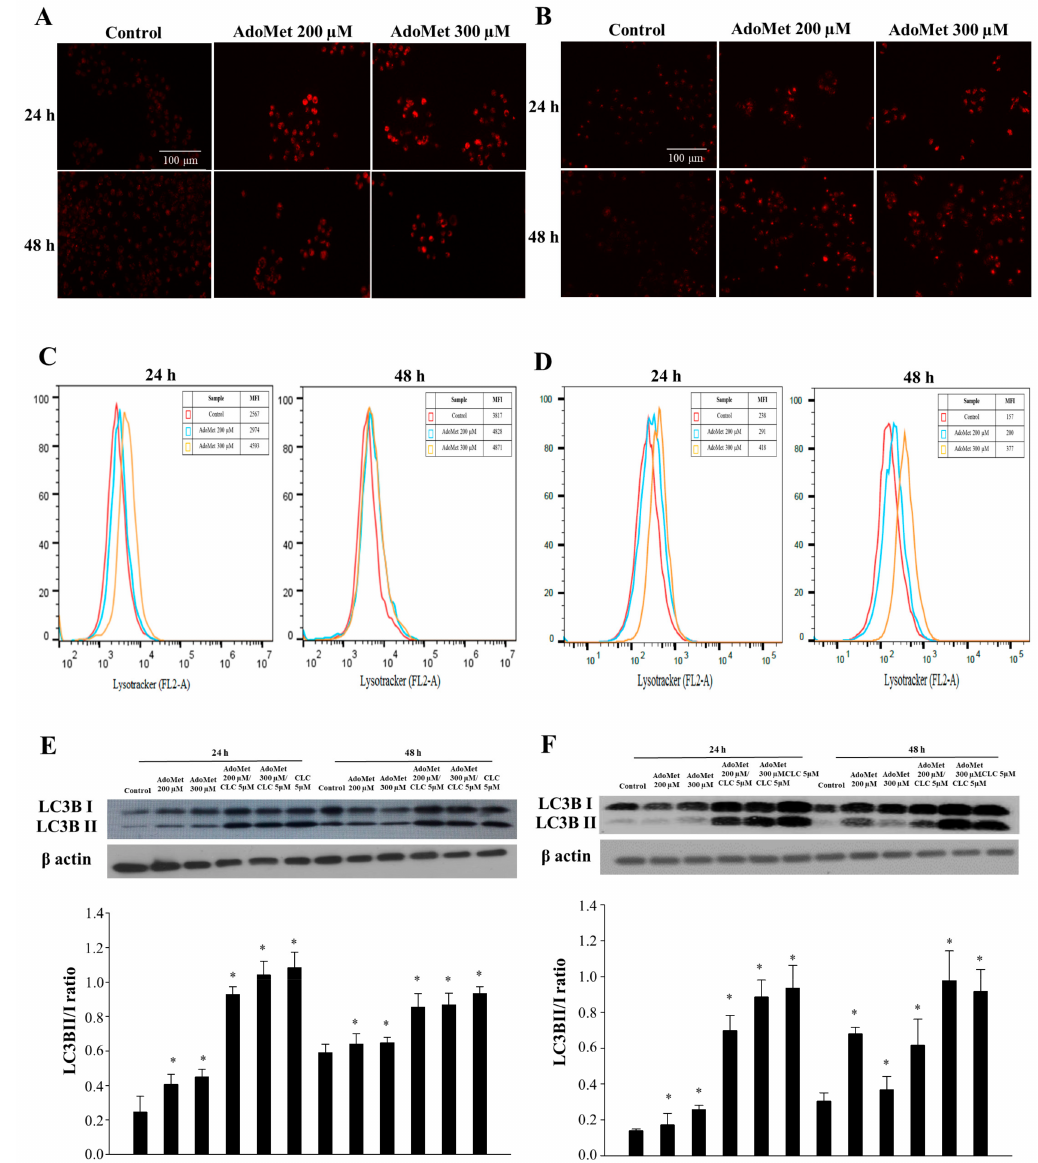
Figure 1. E ff ects of AdoMet on autophagic process in LSCC. Representative images of LTR staining of ( A ) JHU-SCC-011 and ( B ) HNO210 cells treated, or not (Control), with 200 and 300 µ M AdoMet for 24 and 48 h analyzed by fluorescence microscopy. ( C ) JHU-SCC-011 and ( D ) HNO210 cells were treated, or not (Control), with the same concentrations of AdoMet at indicated times and flow cytometry analysis was performed. At least 2 × 10 4 events were acquired in log mode. For the quantitative evaluation of LTR, FlowJo software was used to calculate median fluorescence intensities (MFI) by the formula (MFI-treated / MFI-control). Analysis was carried out by triplicate determination on at least three separate experiments. Western blot assay of ( E ) JHU-SCC-011 and ( F ) HNO210 cells for the expression of autophagy-related markers LC3B. Cells were cultured in medium, supplemented, or not (Control), with 200 or 300 µ M AdoMet for 24 and 48 h, alone or in combination with 5 µ M CLC. Graphs show the densitometric intensity of LC3B-II / I bands ratio. The protein intensities were expressed as arbitrary units (* p < 0.05 versus control cells). For the equal loading of protein in the lanes, β -actin was used. The experiments were repeated at least three times and always gave similar results. Uncropped images of Western blots are reported in Figure